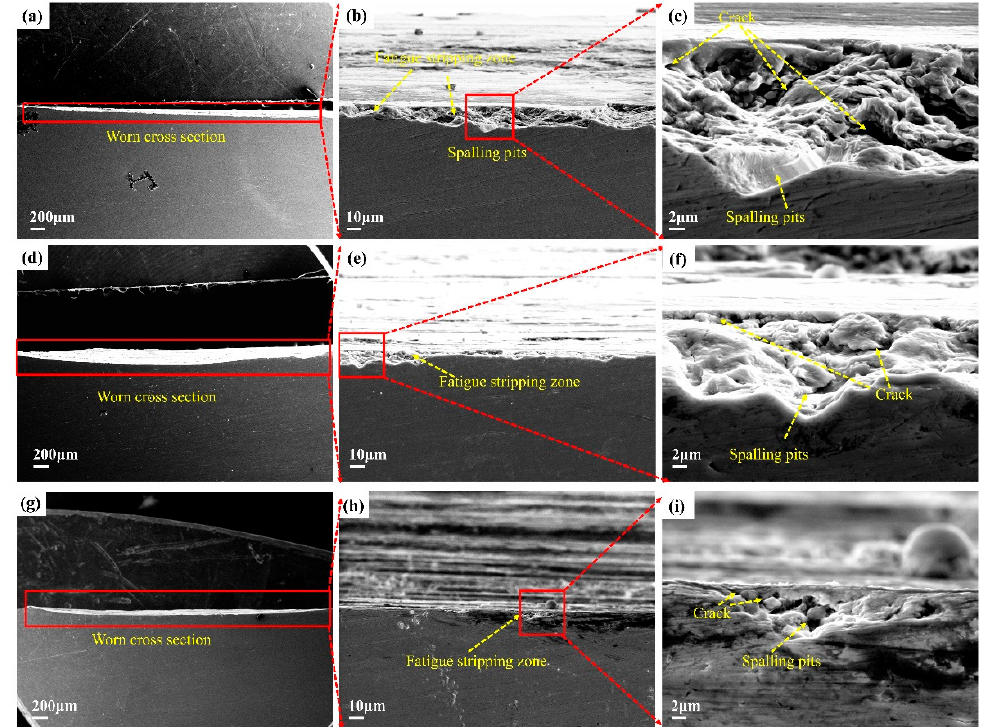
Figure 15. Scanning electron microscope images showing the surface morphology of the cross-sectional abrasions of AISI 316L specimens ( a – c ), Ti2 specimens ( d – f ), and Zr1 specimens ( g – i ) under dry friction conditions.